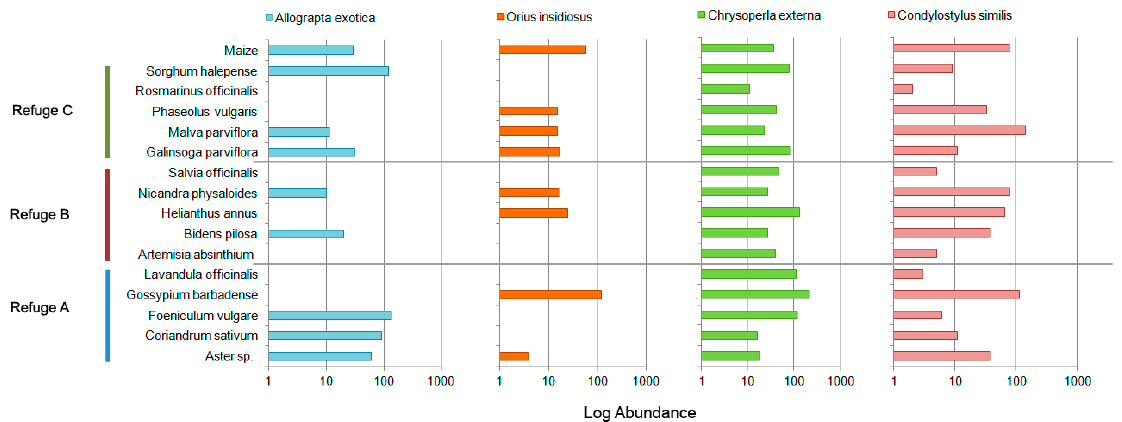
Figure 5. Log abundance of the four main predators occurring in maize, in every refuge plant.